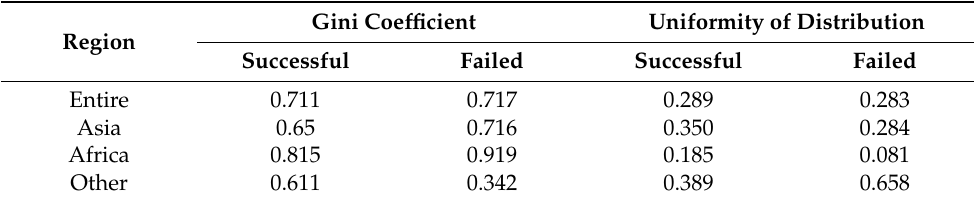
Table 4. Gini coefficient and distribution uniformity measurement